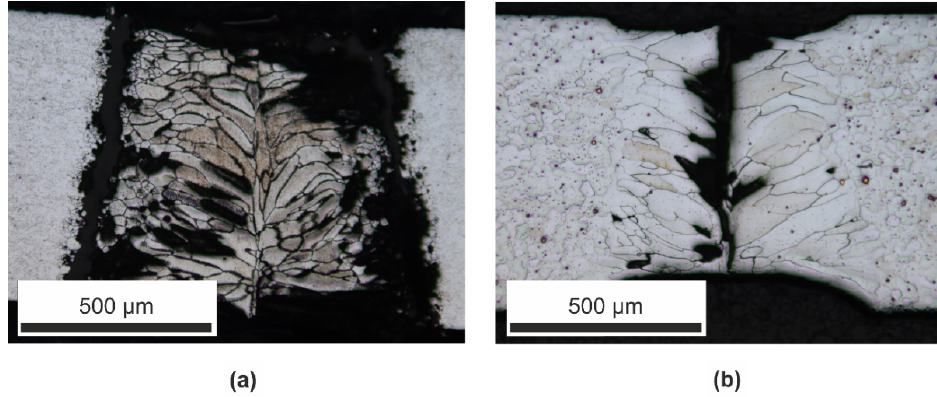
Figure 5. Optical micrographs of ( a ) AISI 430 and ( b ) AISI 430Ti following exposure to 16% boiling sulfuric acid for a duration of 20 h.